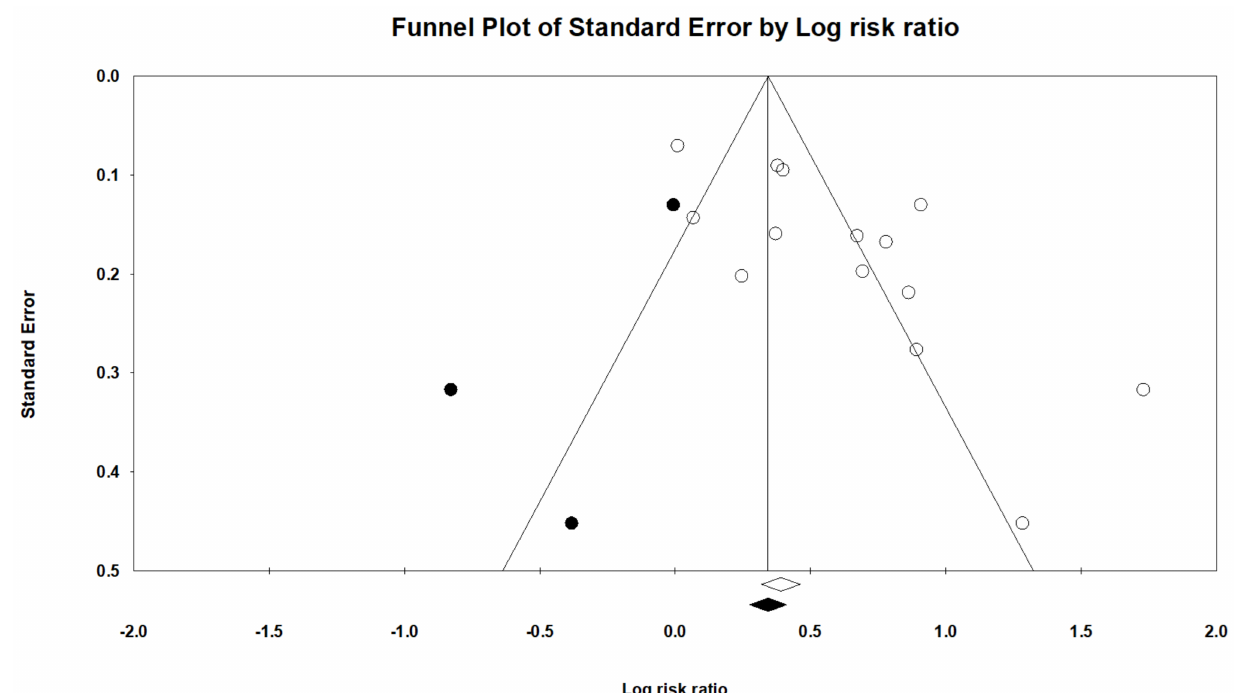
Figure 4. Filled funnel plot of gastric cancer among patients with